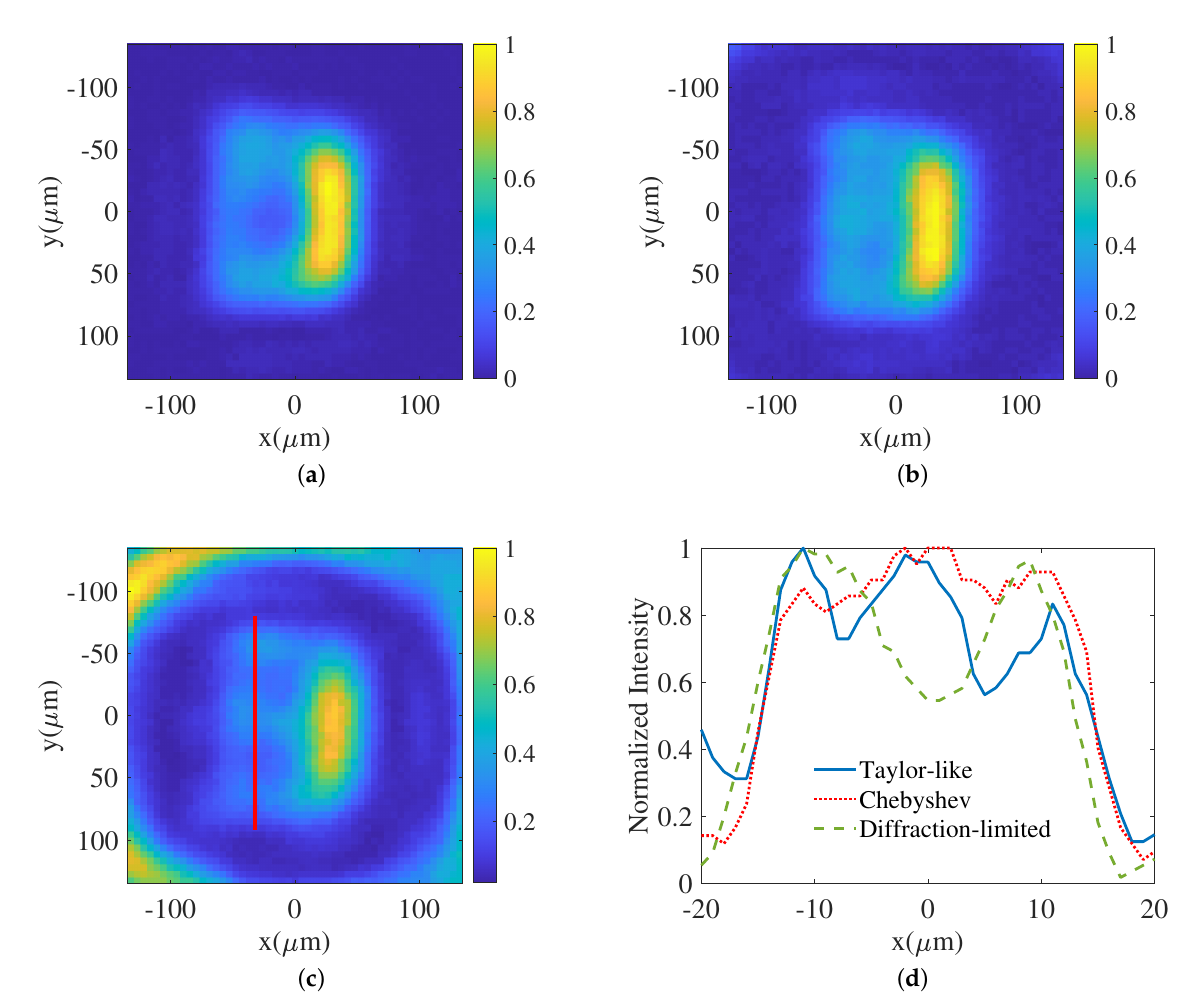
Figure 15. The experimental results of imaging a mask with the letter E ( a ) with the diffraction-limited point-spread function; ( b ) with a super-oscillatory Chebyshev point-spread function; ( c ) with a super-oscillatory Taylor-like point-spread function. ( d ) Intensity distribution along the red line shown in ( c ) compared with the corresponding ones in ( a , b ). Taylor-like (blue line) has the lowest two dips between three peaks (indicating the three branches of the letter E) compared to the Chebyshev (red dotted line). The diffraction-limited (green dashed line) cannot resolve the three